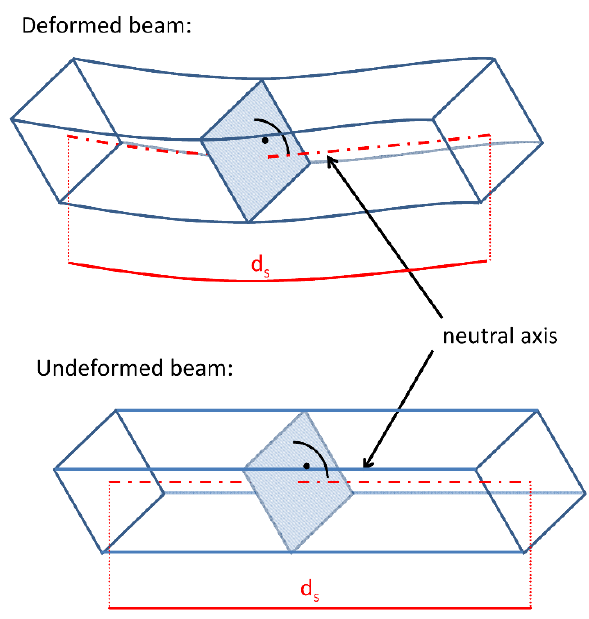
Figure 1. Schematic of the assumptions of the deformations